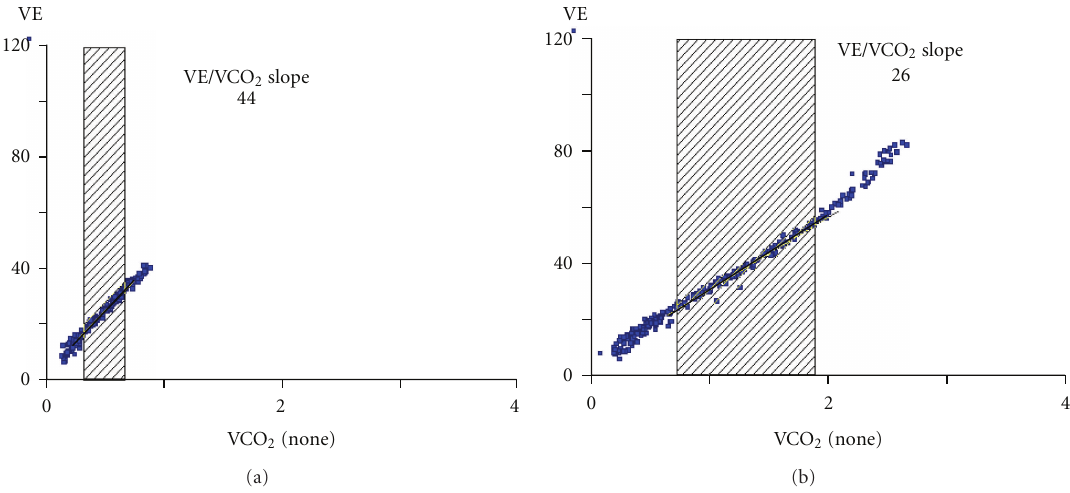
Figure 4: VE/VCO 2 slope in an heart failure patient (a) and an healthy control